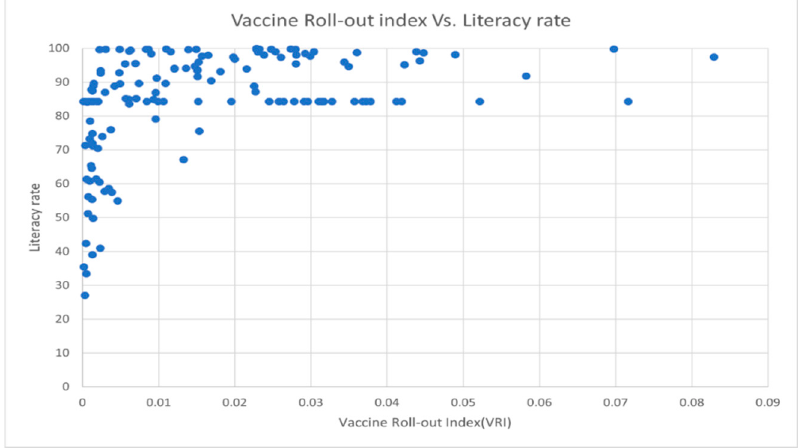
Figure 2. Vaccine Roll-out Index ( VRI ) versus Literacy rate (Adult literacy rate is the percentage of people aged 15 years and above who can both read and write with a clear understanding of a short simple statement about their everyday life).